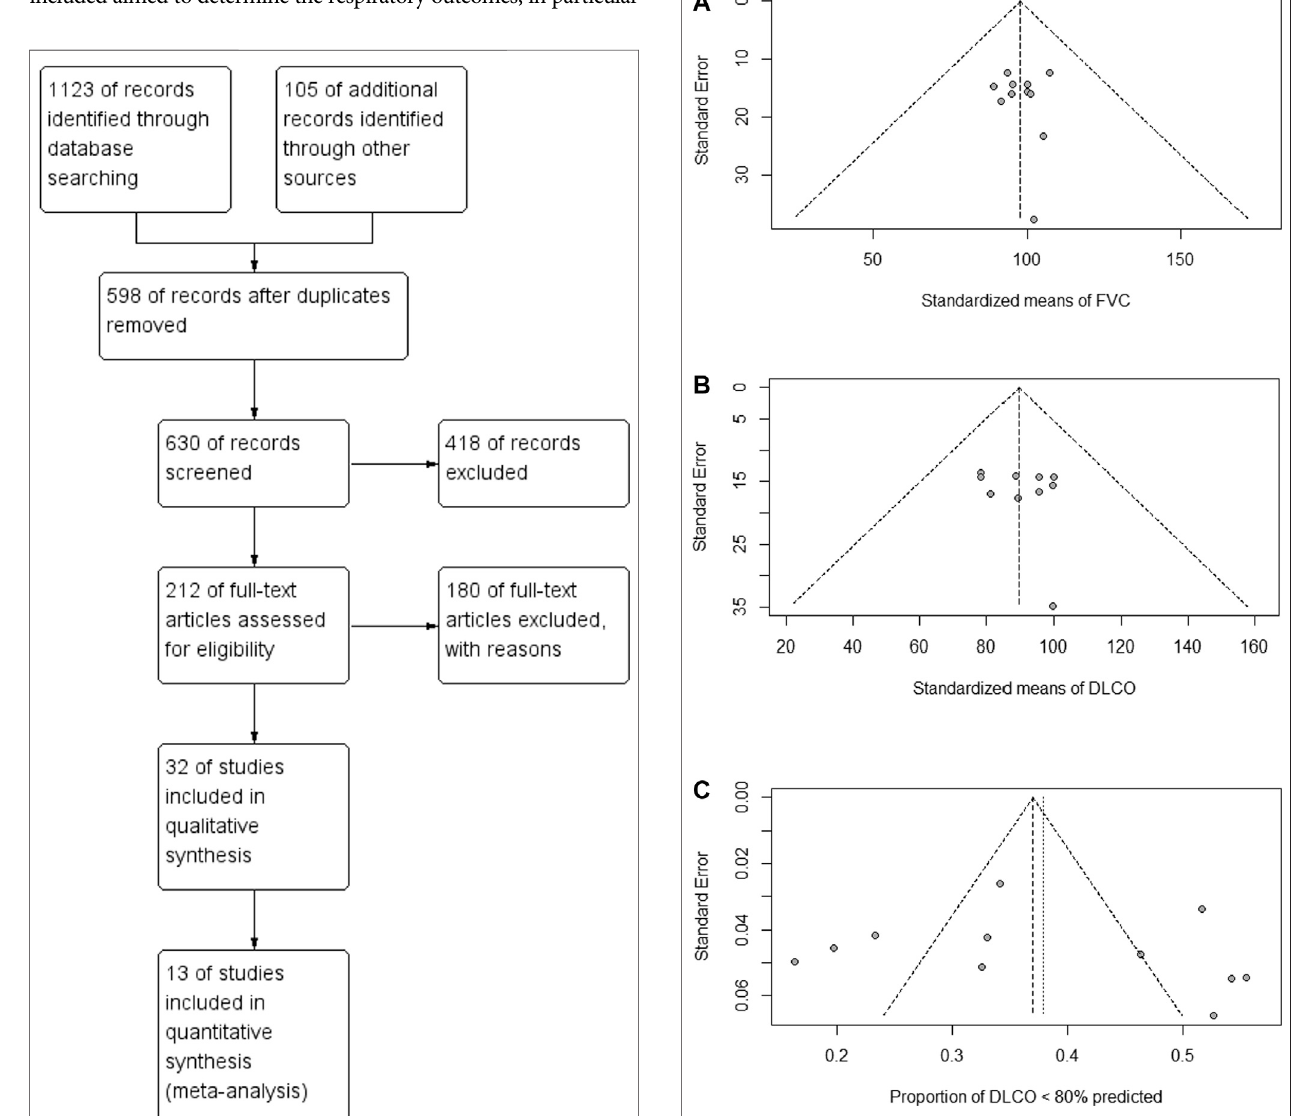
FIGURE2| Nopublicationbiasofthemeta-analysis.FunnelplotsofFVC (% ofpredicted) (A) , DLCO (% of predicted) (B) and DLCO < 80% ofpredicted (C) were shown. Each dot represents a